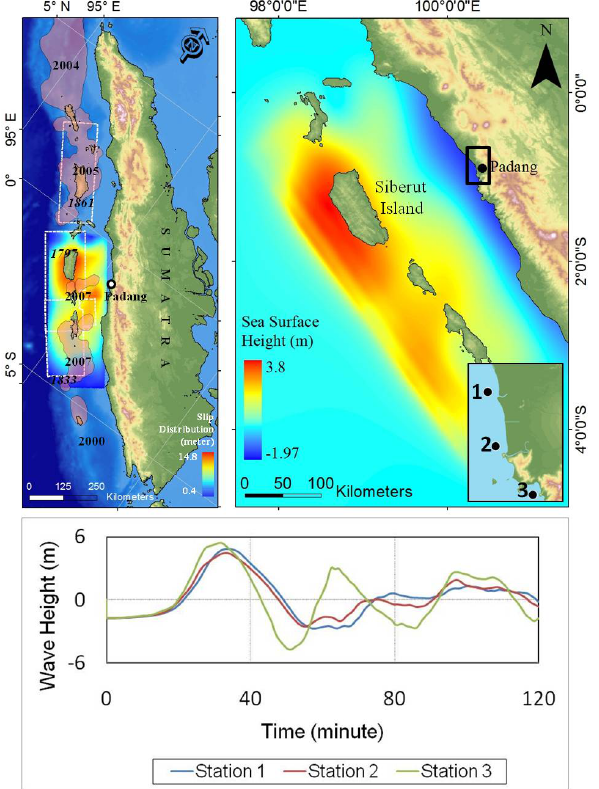
Fig. 1. Tsunami source scenario (left hand side, Natawidjaja et al., 2009) and the calculated sea floor displacement (right hand side). Inset on the right hand side is the position of numerical tide gauges, and the computed tsunami wave forms at the bottom figure. White dotted lines are the historical faults, indicated by year in italics (Natawidjaja et al., 2006); transparent rupture zones are the result of recent seismic activity, indicated by year in bold (Sieh et al., 2008).